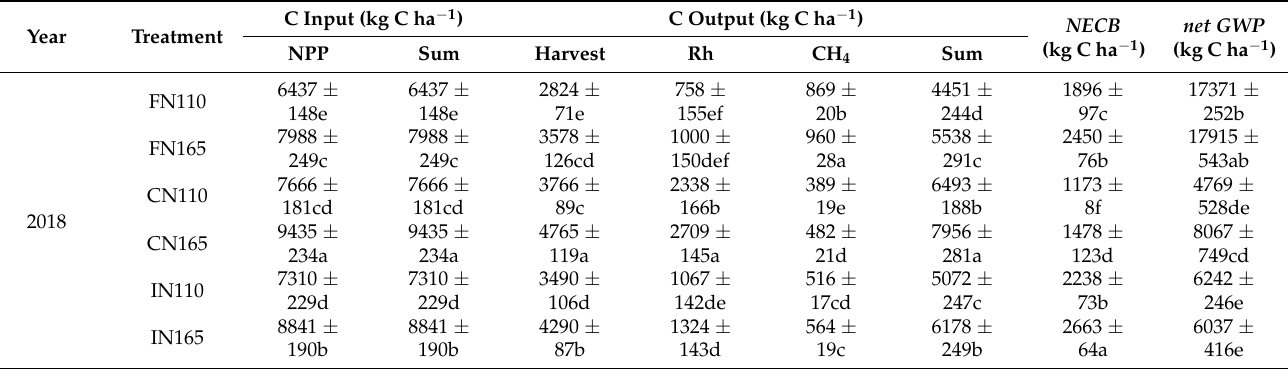
Table 3. Seasonal Rh , CH 4 fluxes, NECB , and net GWP in a paddy field after the implementation of water-saving